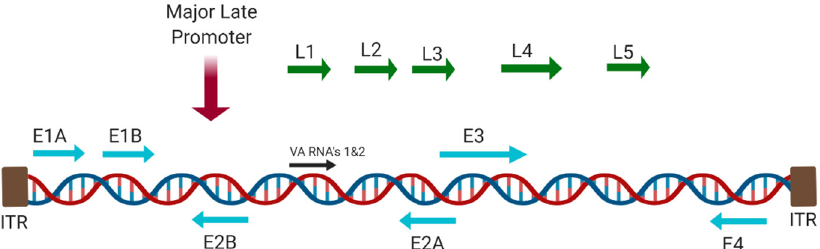
Figure 4. Adenoviral genome, highlighting key genes which are often modified or deleted in oncolytic therapeutics. Created with https: // BioRender.com.